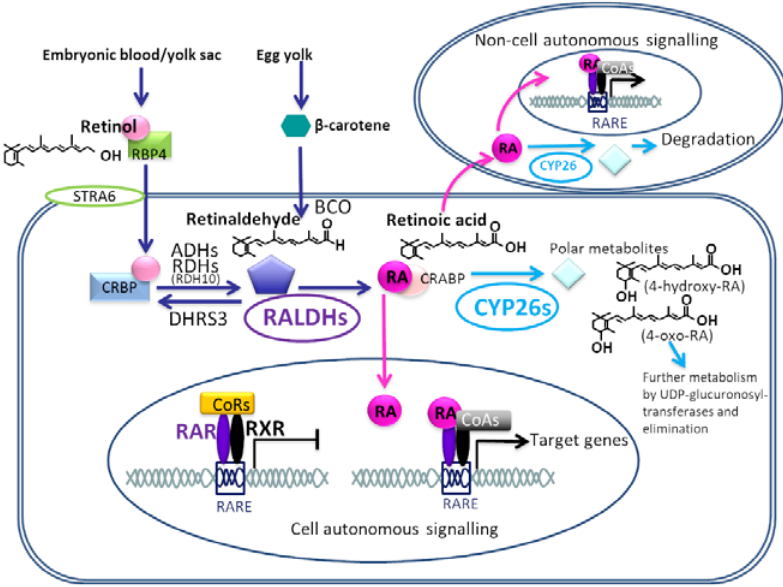
Figure 1. Schematic of the retinoic acid signalling pathway during development. Maternal diet-derived retinol/ in blood/yolk sac/yolk of embryo bound to retinol binding protein 4 (RBP4) enter cellular cytoplasm via binding to membrane bound RBP/RA complex receptor STRA6 (Stimulated by Retinoic Acid 6). Retinol is then bound to cellular retinol binding protein (CRBP) and reversibly oxidised